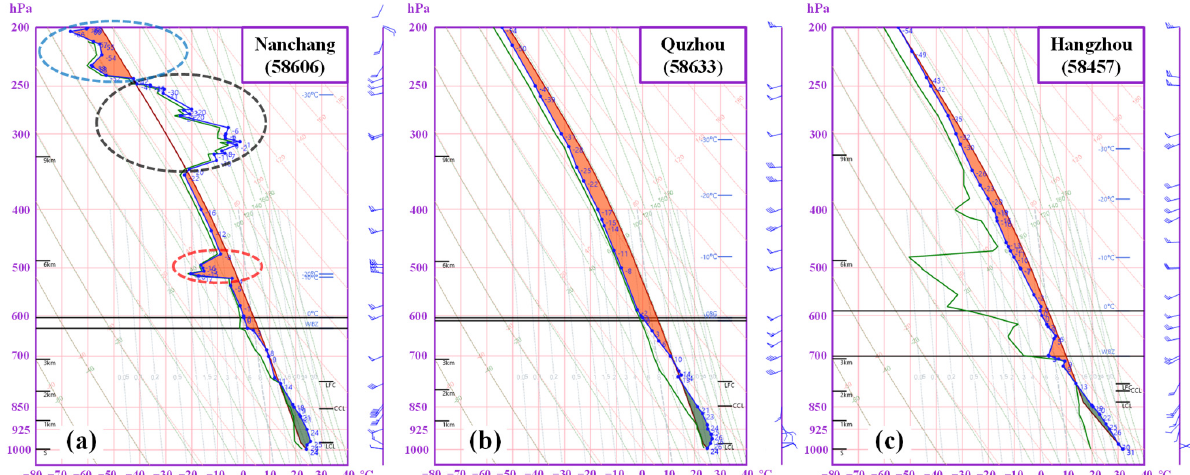
Figure 3. T–logP plots of the soundings taken at ( a ) Nanchang station, ( b ) Quzhou station, and ( c ) Hangzhou station at 2000 BT on 10 May 2021. The red and green colors represent CAPE and convective inhibition (CIN), respectively.